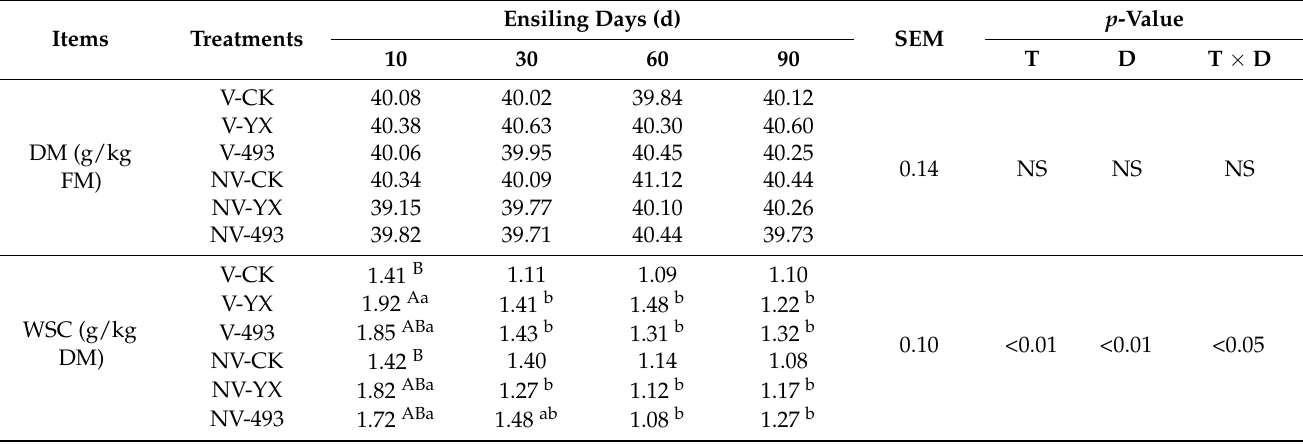
Table 1. Effects of vacuum treatment and inoculants on chemical compositions in alfalfa silage at different silage opening times. Items